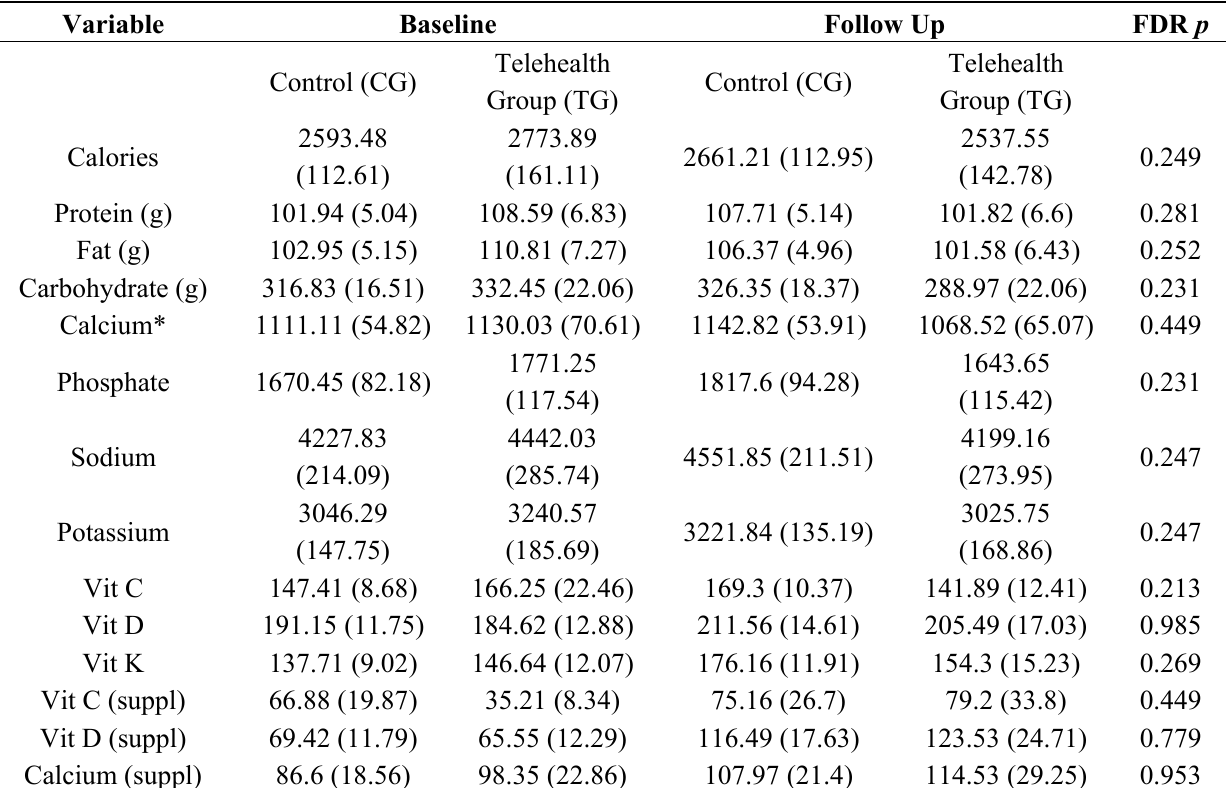
Table 4. Dietary intake pre- and